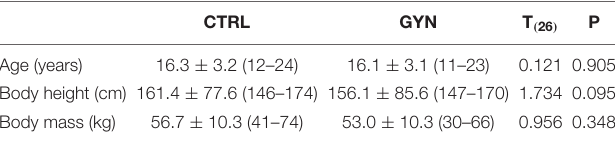
TABLE 1 | Characteristics (age, height and body mass) of the participants included in the Acrobatic Gymnastics group (GYN, n = 14) and age-matched non-gymnasts [controls (CTRL), n =